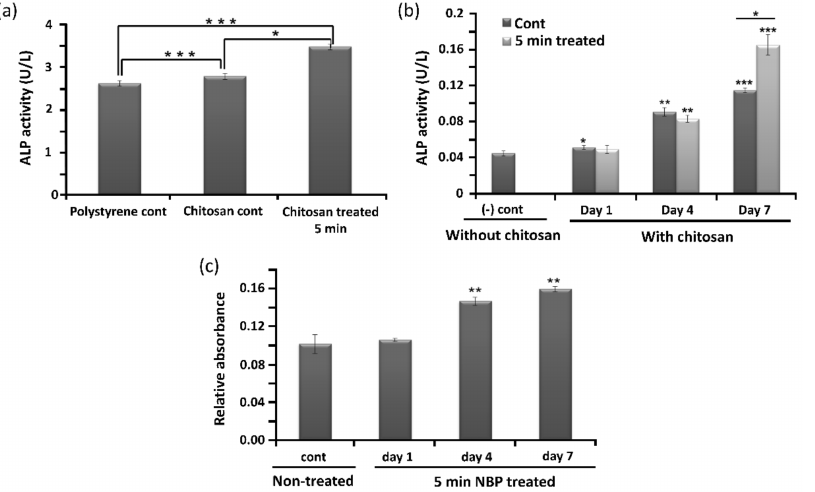
Figure 5. Promotion of osteogenic differentiation of bone marrow-derived stem cells (BMSCs) by Non-thermal, biocompatible plasma (NBP)-treatment of the chitosan scaffold. Alkaline phosphatase (ALP) ( a ) activity assay of BMSCs seeded on polystyrene and chitosan control scaffolds, and chitosan scaffolds treated for 5 min with DBD-based NBP. ( b ) ALP activity of control without chitosan and with chitosan (control and 5-min NBP-treated) at 1, 4, and 7 days. ( c ) Detection of mineralization on BMSCs on untreated (control) and 5-min NBP-treated scaffolds at days 1, 4, and 7. Significant differences were indicated as * p < 0.05, ** p < 0.01, and *** p < 0.0001 by Tukey test after one-way analysis of variance. Data are presented as mean ± SD from three independent